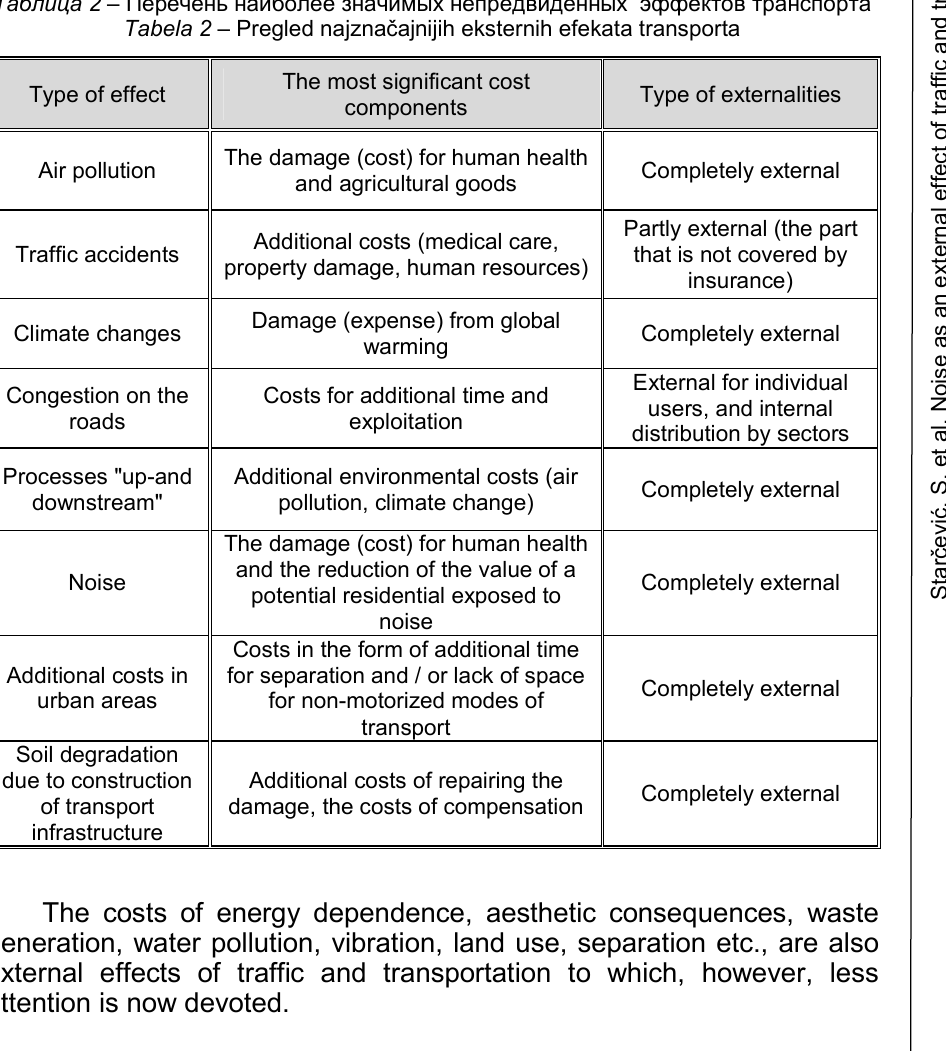
Table 2 – Overview of the most important external effects of transport Таблица 2 – Перечень наиболее значимых непредвиденных эффектов